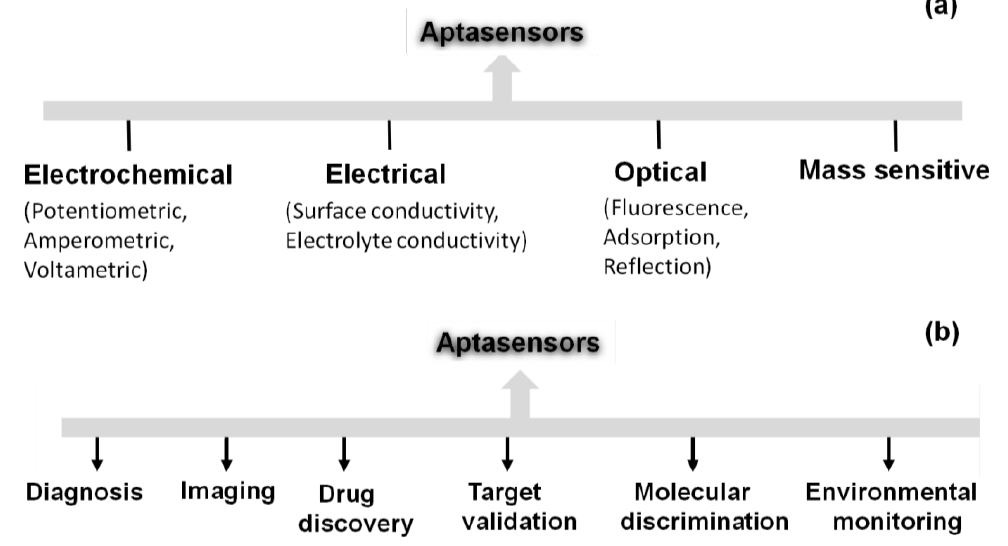
Figure 3. ( a ) Classification for aptasensors; ( b ) Aptasensor applications with a wide range of